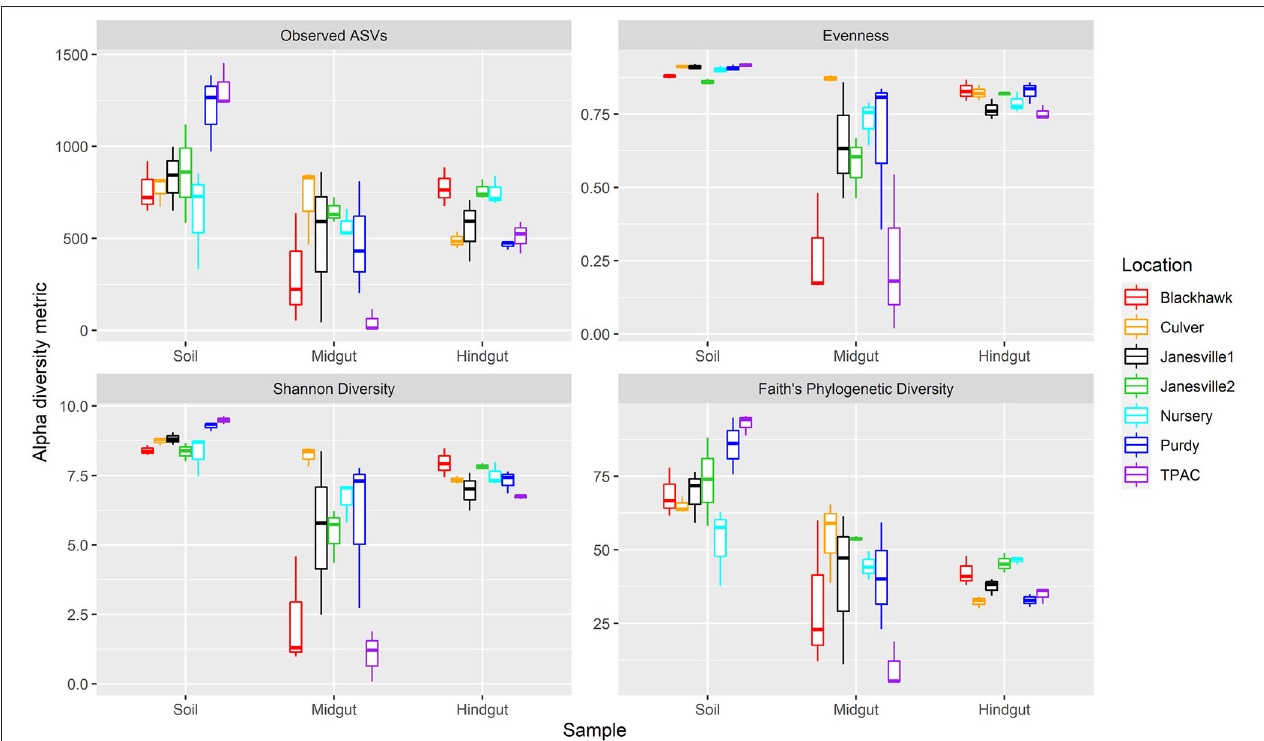
FIGURE 3 | Alpha diversity for prokaryotic communities in guts from third instar Japanese beetle ( P. japonica ) larvae and associated soil. Boxplots show median, interquartile range, and 1.5 × the interquartile range per location. Regardless of the α -diversity metric, the influence of location on α -diversity varied with compartment (ART, location × compartment, p < 0.001). n = 3 for each compartment at each location. Refer to Supplementary Table 4 for detailed statistical